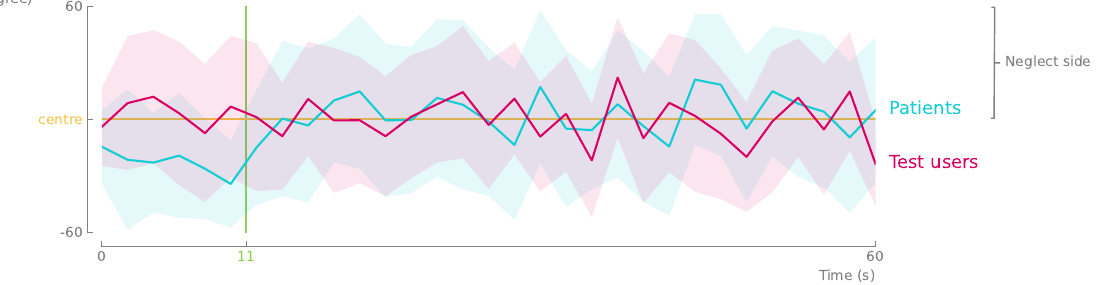
Figure 12. The average head direction of the first 60 s of all the Assessment tasks is aggregated and plotted for the clinical patients (blue) and the non-clinical test users (pink). The patients indicate a bias of around 20 degrees towards their non-neglected side for the first 11 s, the average time until the first key is played (green). This bias is corrected after this first stimulus, resulting in an average head direction fluctuating around the middle for the remainder of the 60